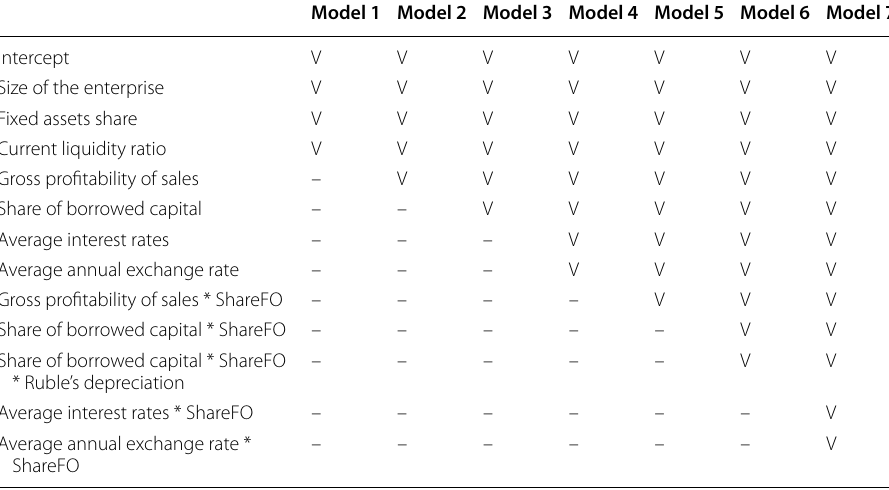
Table 2 Types of investigated models of net return on